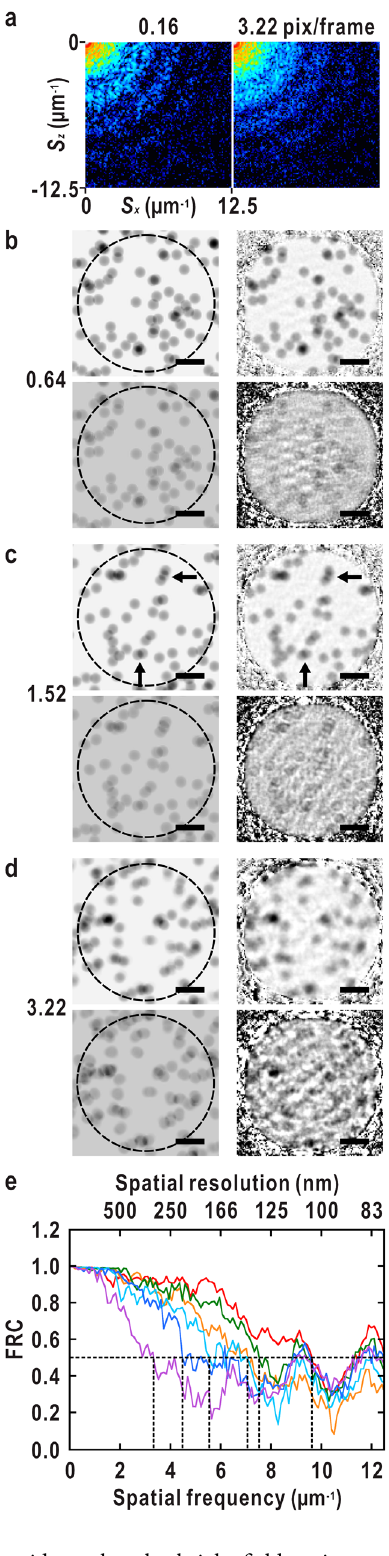
Fig. 7 Effect of the amount of structural variation on ptychography. a Simulated diffraction intensity patterns of models at 90%w/v and 283 K (left) and 50%w/v and 343 K (right) accumulated over the dwell time. The root mean square displacements (RMSDs) of each model are indicated at the top. Object transmission functions of the models averaged over the frame time (left) and the corresponding reconstructions by the ptychography (right) at b 90%w/v and 323 K, c 80%w/v and 343 K, and d 50%w/v and 343 K, respectively. Phase (upper) and absorption (lower) images at frame number 500 are shown. The illuminated areas on the models are indicated with the broken circles. The particles indicated with the arrows in c show a different arrangement between the model and reconstruction. The RMSDs of each model are indicated at the left in pixels per frame. e Temporal-averaged Fourier ring correlation (FRC) curves of each model, plotted in order of increasing RMSDs with red, orange, green, light blue, blue, and purple solid lines. The broken line indicates a threshold of 0.5 and corresponding spatial frequency. The colour scale for diffraction patterns and grayscale for the object images are same as in Fig. 4. Scale bars indicate 1